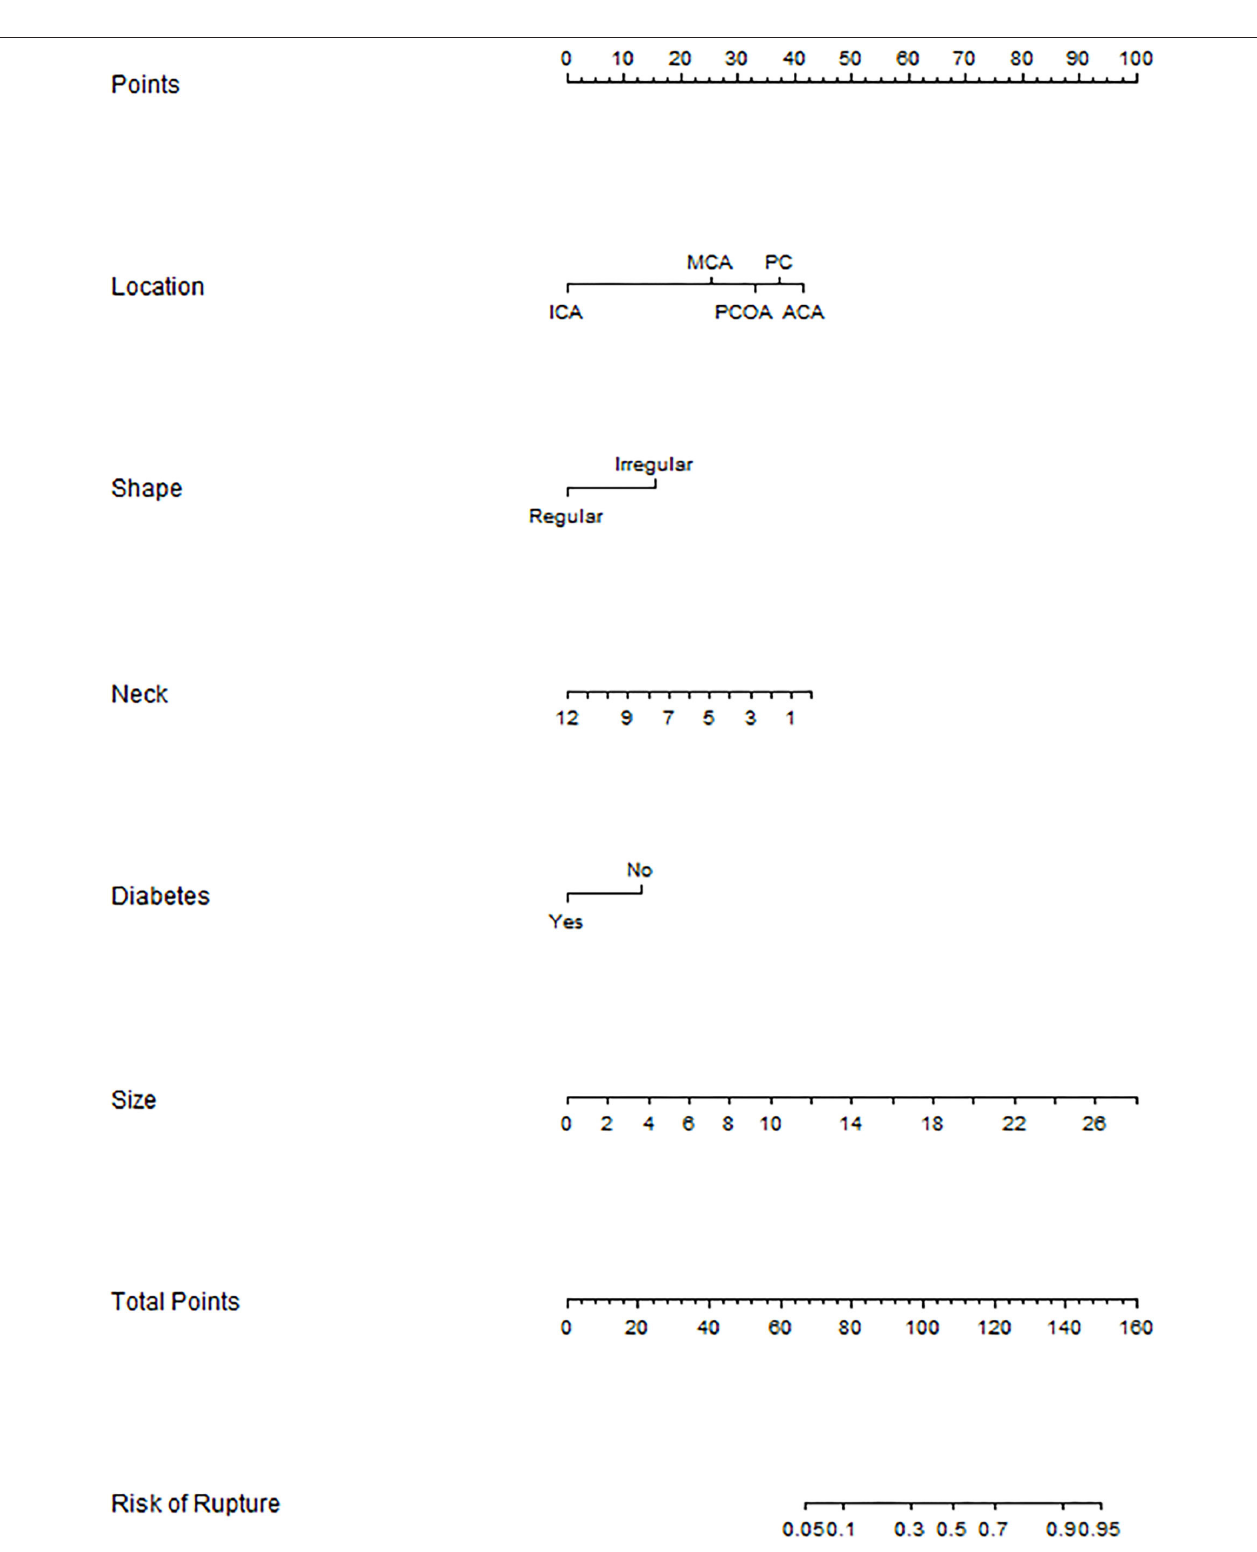
FIGURE 1 | Nomogram for rupture risk assessment of multiple aneurysms. ICA, internal carotid artery; MCA, middle cerebral artery; PCOA, posterior communicating artery; PC, posterior circulation; ACA, anterior cerebral artery.